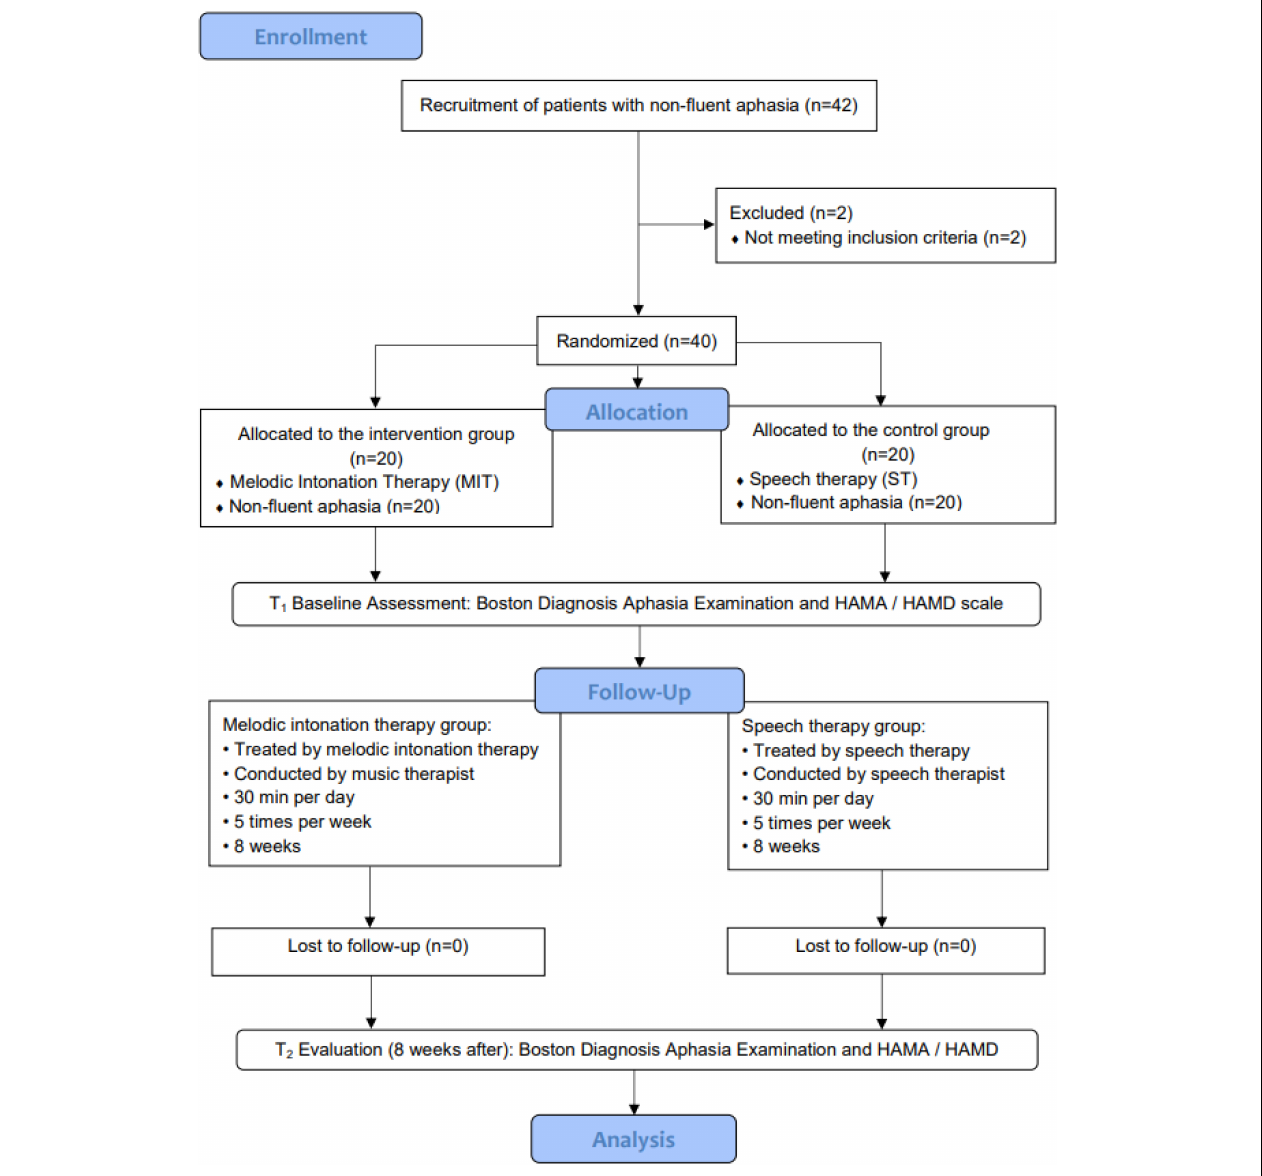
FIGURE 1 | Flow diagram, consort flowchart for participants’ recruitment and